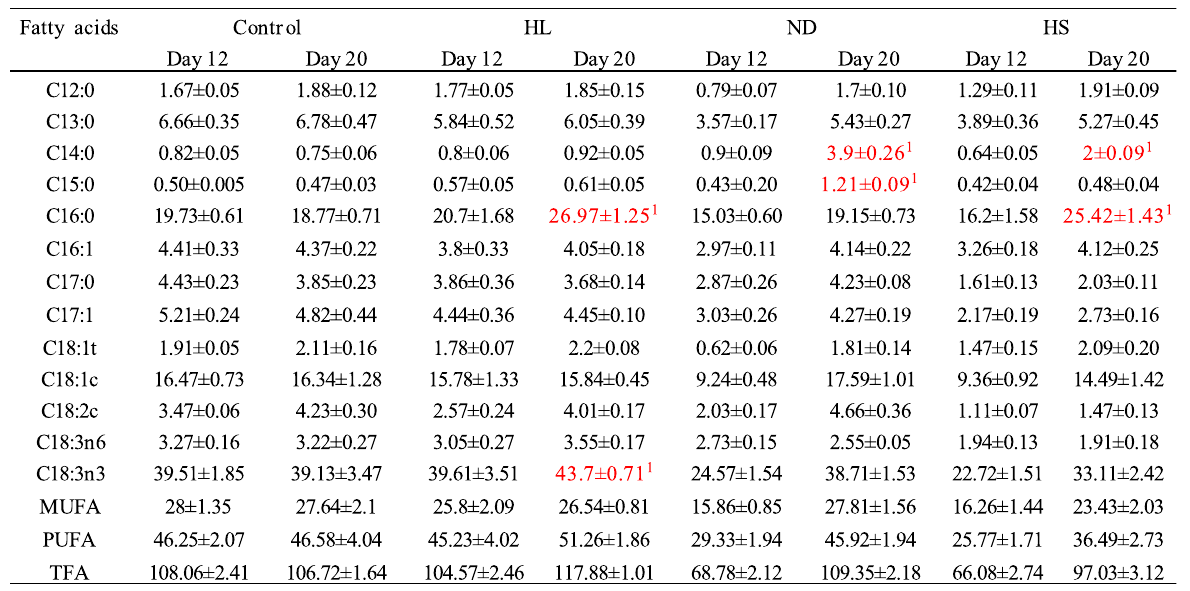
Table 1 The fatty acid composition and contents ( μ g/mg) in D. salina Y6 under the tested abiotic-stress conditions